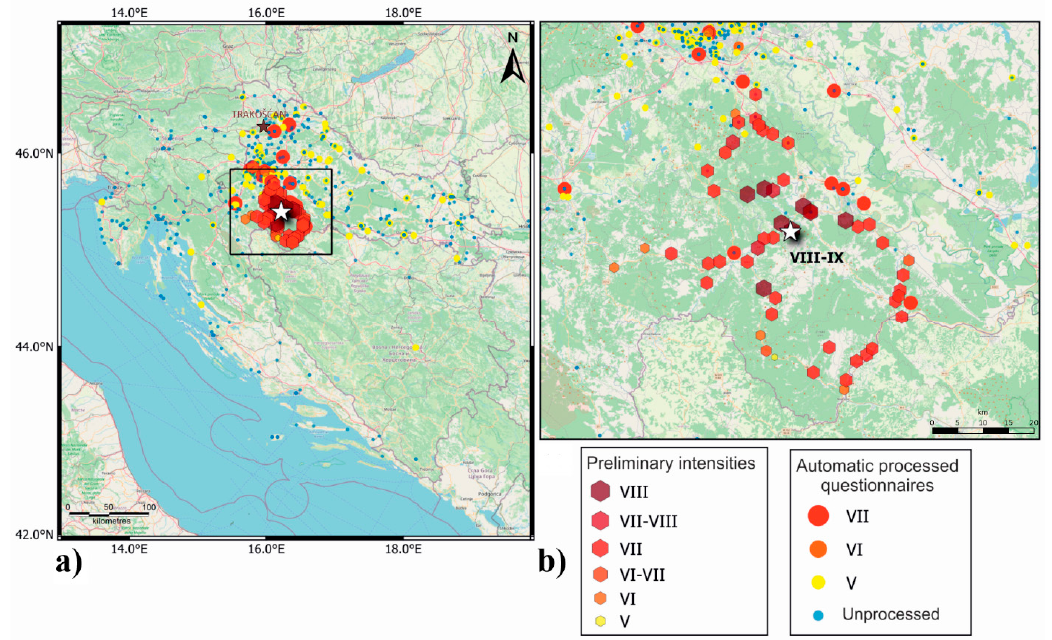
Figure 4. Spatial distribution of the intensities (in EMS) of the main M6.2 event (location marked with white star, after [7]). ( a ) A preliminary intensity map for the M6.2 Petrinja 2020 earthquake, which was obtained by automatic processing of questionnaires (circles) and by a macroseismic field survey (preliminary values, which are marked by hexagonal shapes). Location of Trakoš ć an Castle is marked with a brown star; ( b ) Intensities in the wider Petrinja area, which is indicated by a rectangle in ( a ).